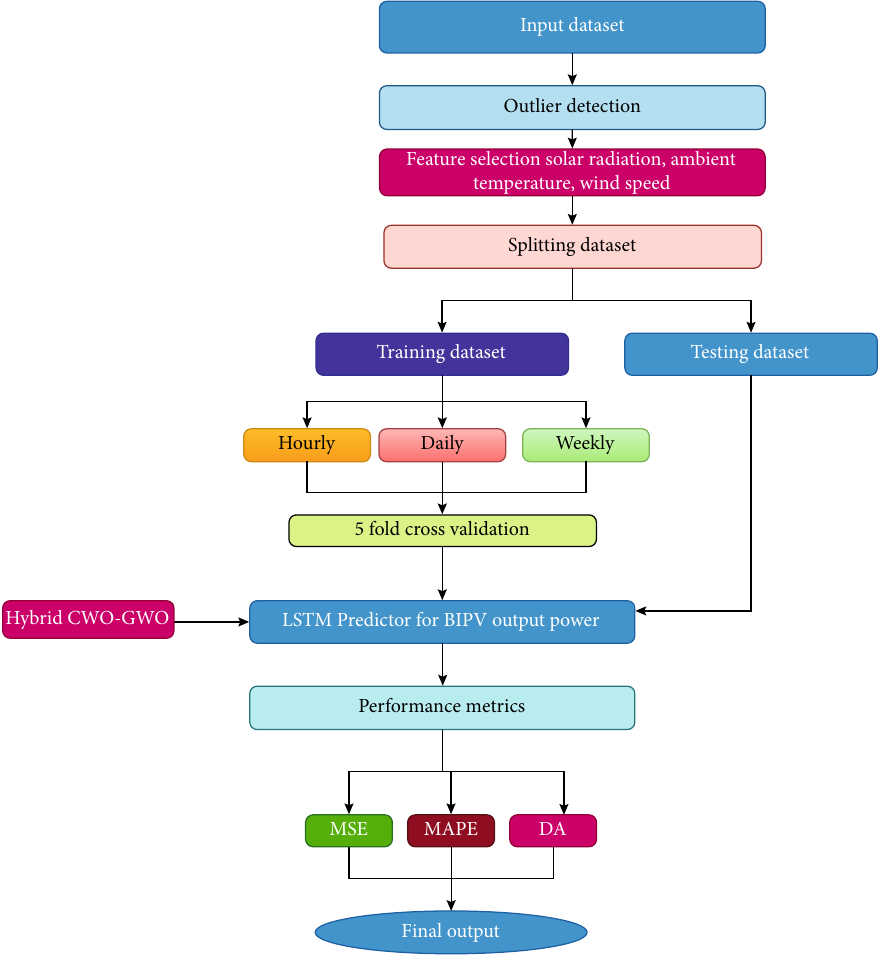
Figure 2: Overall methodology adopted in the